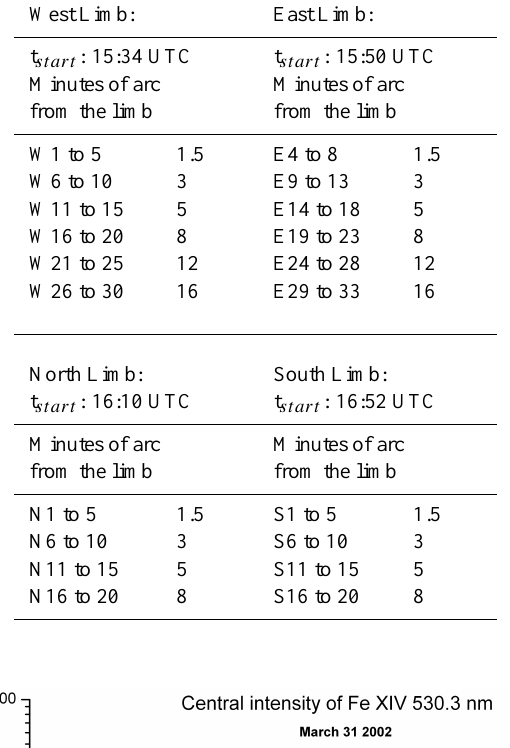
Table 1. Times, positions and numbers of the analysed slit spectra (see Fig. 1).